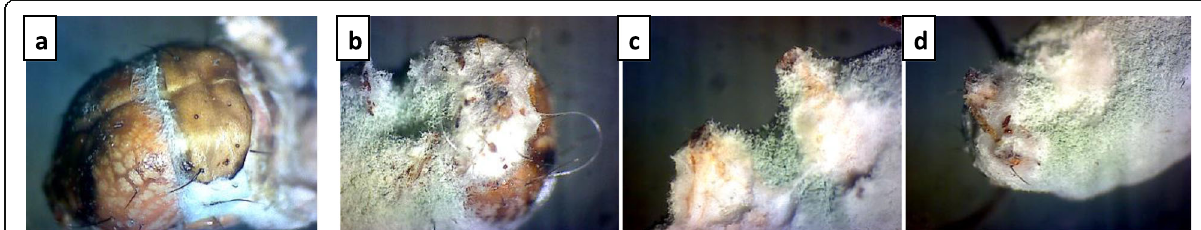
Fig. 7 Mycosis of Metarhizium rileyi on various body parts of Spodoptera frugiperda